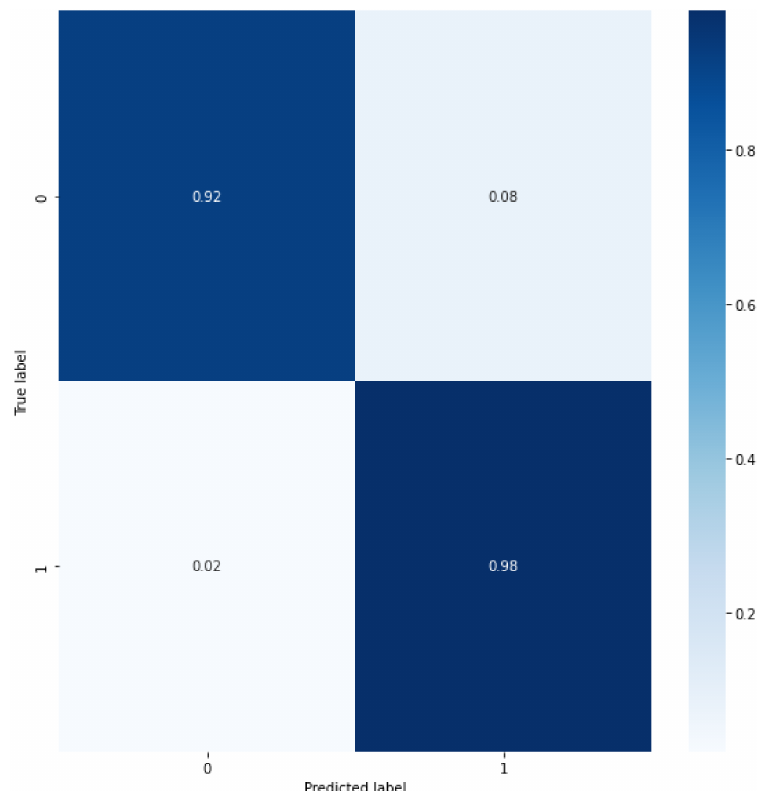
Figure 13. The result of the confusion matrix